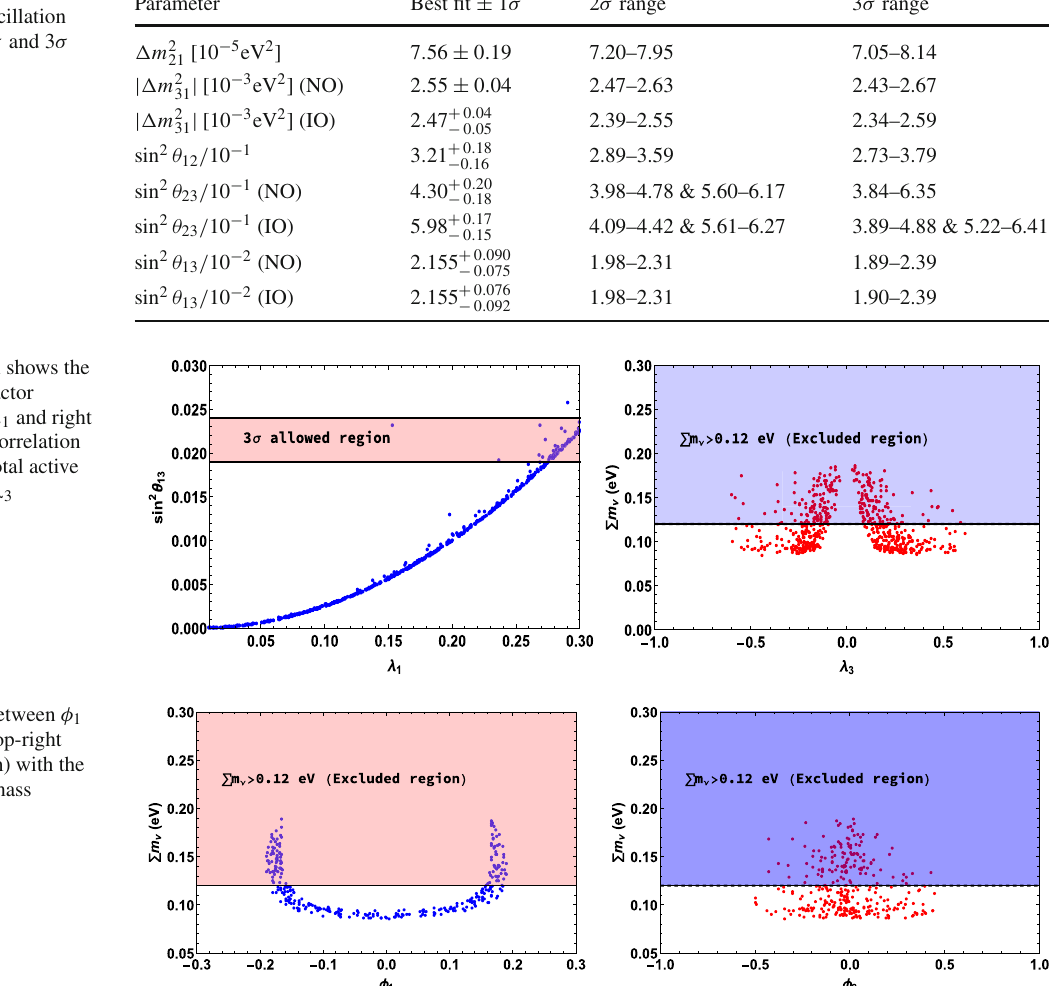
Fig. 3 Correlation between φ 1 (top-left panel), φ 2 (top-right panel) and φ 3 (bottom) with the total active neutrino